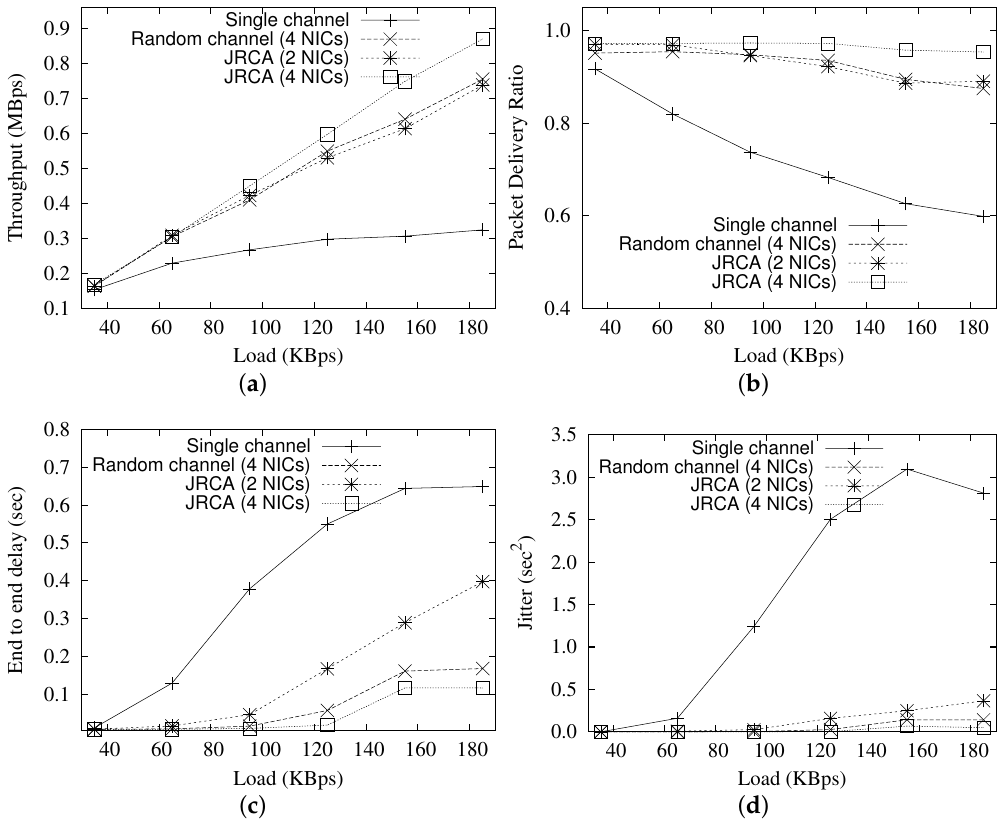
Figure 10. Comparison of ( a ) throughput ( b ) delivery ratio ( c ) delay ( d ) jitter with different loads for multi-channel WOBAN with multiple